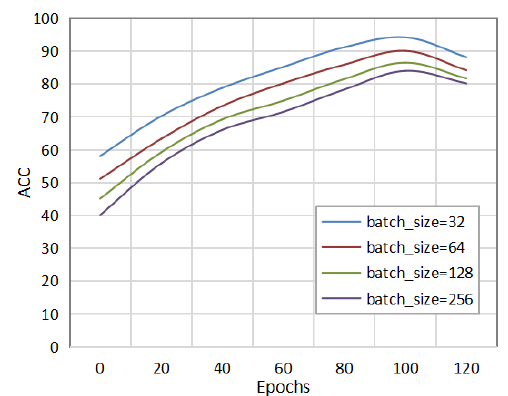
Figure 3. Comparison of experimental results under different